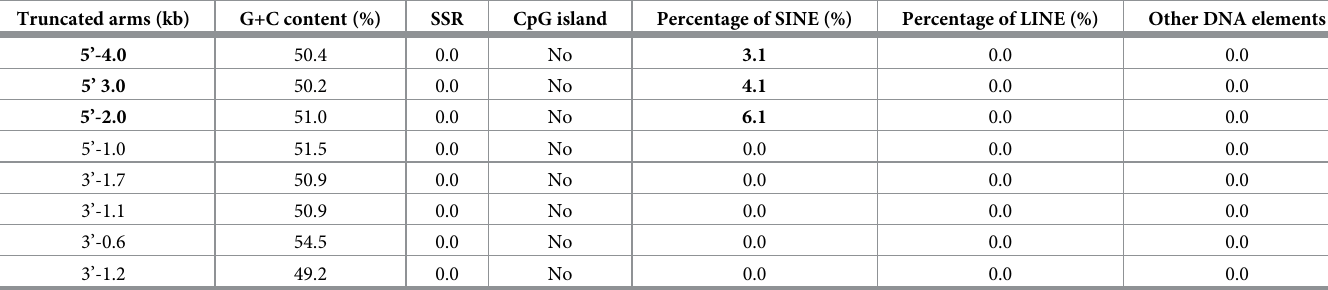
Table 6. Genetic features of the sequences used for creating different 5’ and 3’ truncated homologous